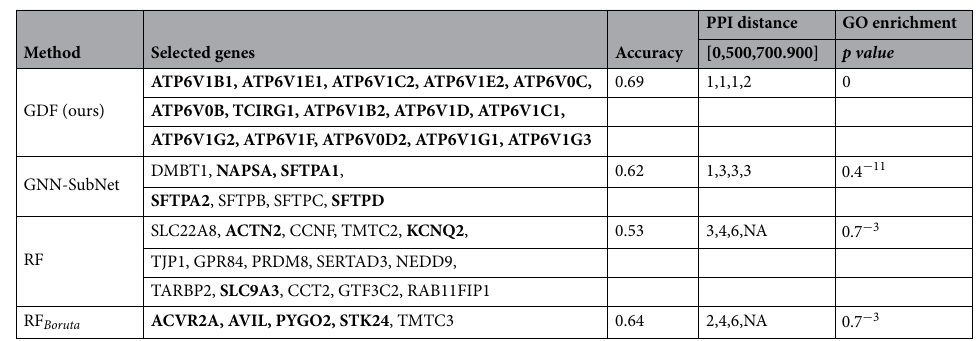
Table 6. Survival experiment. Accuracy of the selected kidney cancer (KIRC) genes. GO term enriched genes are highlighted in bold. The PPI Distance reflects the longest shortest path from one node to the other, given a certain threshold for the confidence of the